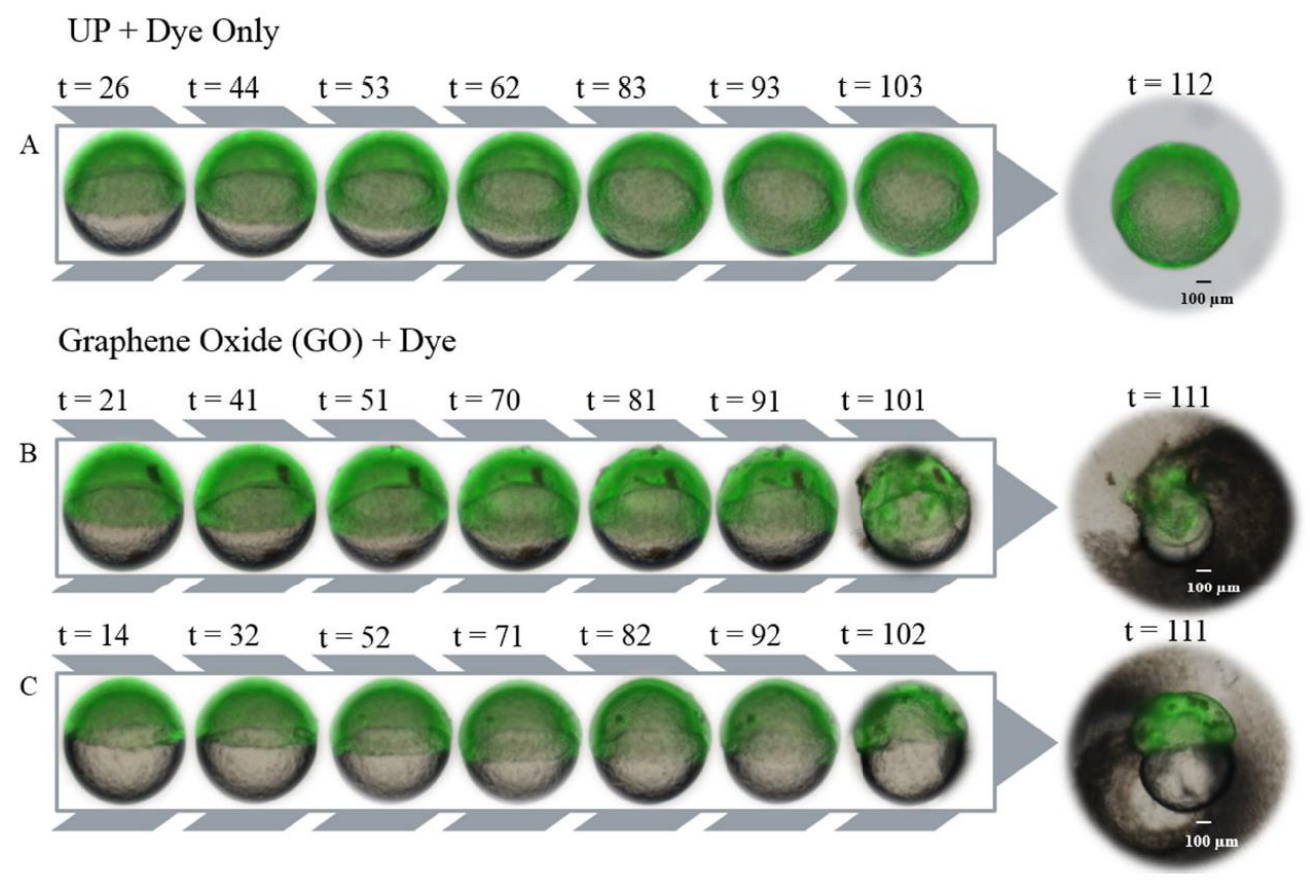
Figure 7. ROS fluorescence imaging of mGO and UP water control embryos. After DCF-DA incu- bation for 30 min, 6 hpf embryos were exposed to 50 µ g/mL mGO or UP water and imaged every 10 min. ( A ) Representative embryo in UP water. The embryo oriented itself so that yolk sac was no longer visible after 83 min post-exposure. ( B ) Embryos exposed to mGO. Observed accumulation of GO particles on the surface of the embryo. Yolk content loss is visible in later timepoints of the images. ( C ) Another embryo exposed to mGO. We can see the accumulation of GO particles on the surface of the embryo. t= minutes post-exposure.